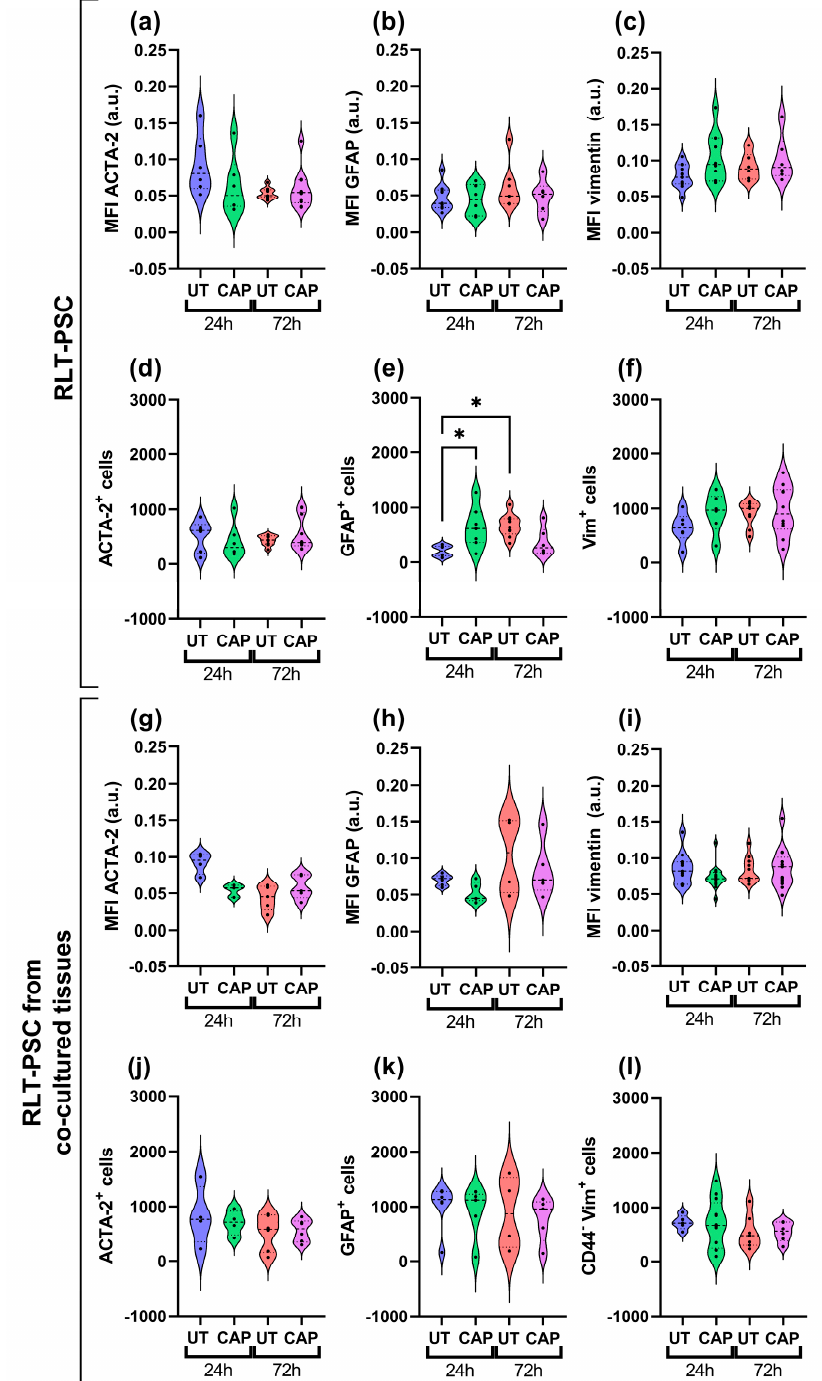
Figure 5. CAP does not alter the activation profile of RLT-PSC cells in ovo. Sections of RLT-PSC and co-cultured RLT-PSC + Mia PaCa-2 from in ovo tissue were stained for GFAP, vimentin (Vim), and ACTA-2. ( a – c , g – i ) Mean fluorescence intensity (MFI) expressed as arbitrary units (a.u.); ( d – f , j – l ) number of cells positive for the corresponding markers. Anti-CD44 antibodies (PDAC cells) were used as a counterstain to discriminate Mia PaCa-2 cells from RLT-PSC. UT = untreated control. n ≥ 4 tissue per condition; each dot represents one tissue. Dashed lines = median; dotted lines = 25% and 75% quartiles; * = p ≤ 0.05.